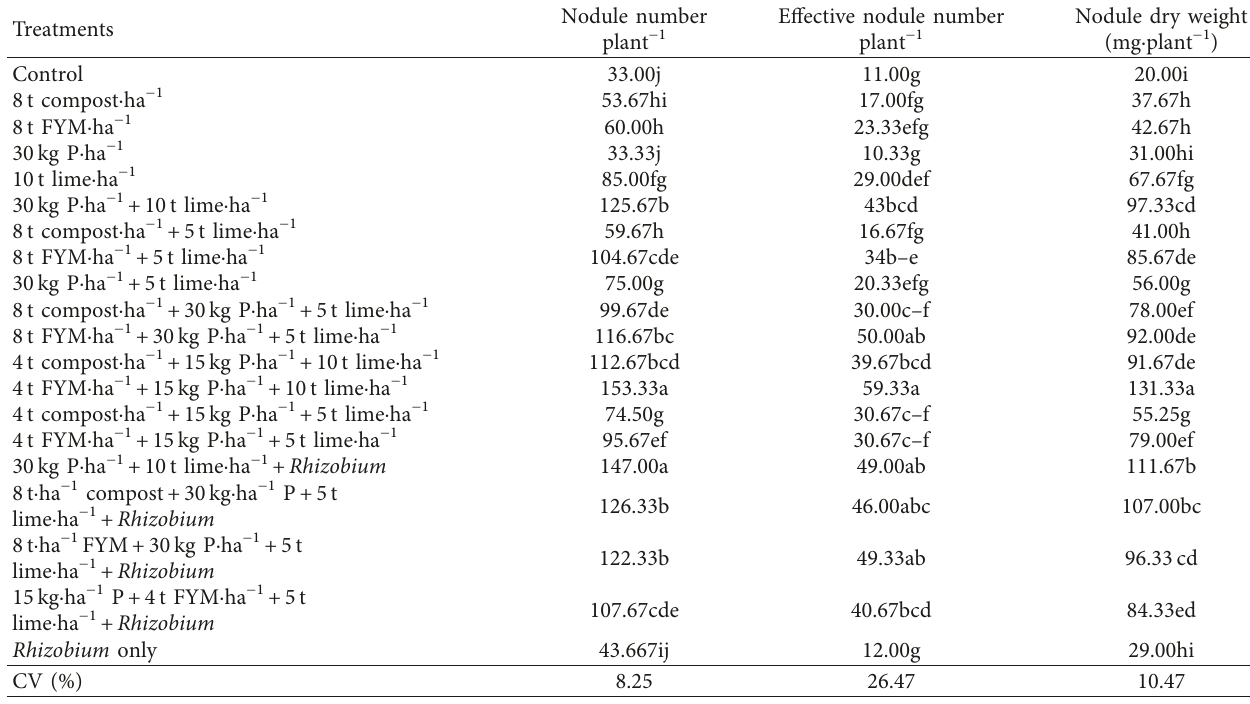
Table 2: Effects of organic and inorganic amendments on the nodulation of faba bean.